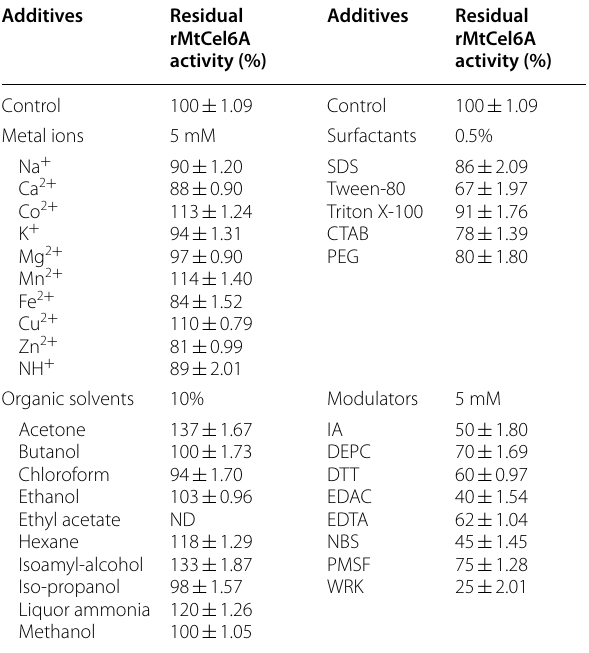
Table 3 Effect of various additives on rMtCel6A